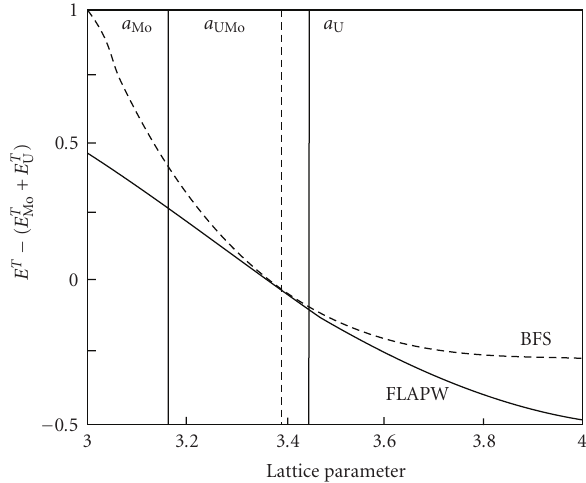
Figure 1: Comparison of the ab initio (see text for the details of the calculations) results (solid curves) and BFS results (dashed curves) as a function of the lattice parameter (in ˚A) for U-Mo in the B2 structure. The vertical lines indicate the equilibrium lattice param- eters of U and Mo in the bcc symmetry of the alloy (solid lines) and B2 U-Mo (dashed line), as computed by the ab initio